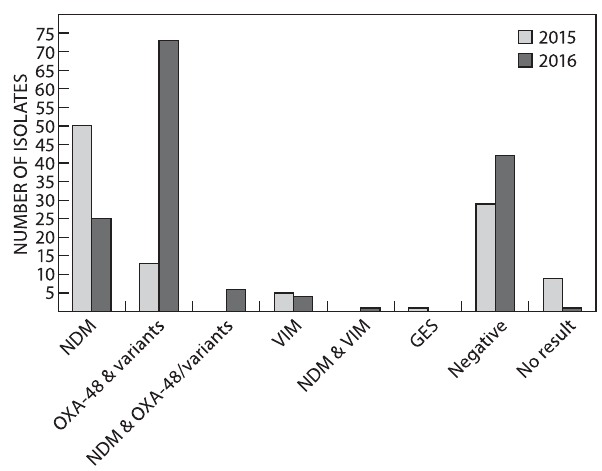
Figure 4: PCR-identi fi ed carbapenemase genes from CRE isolates.